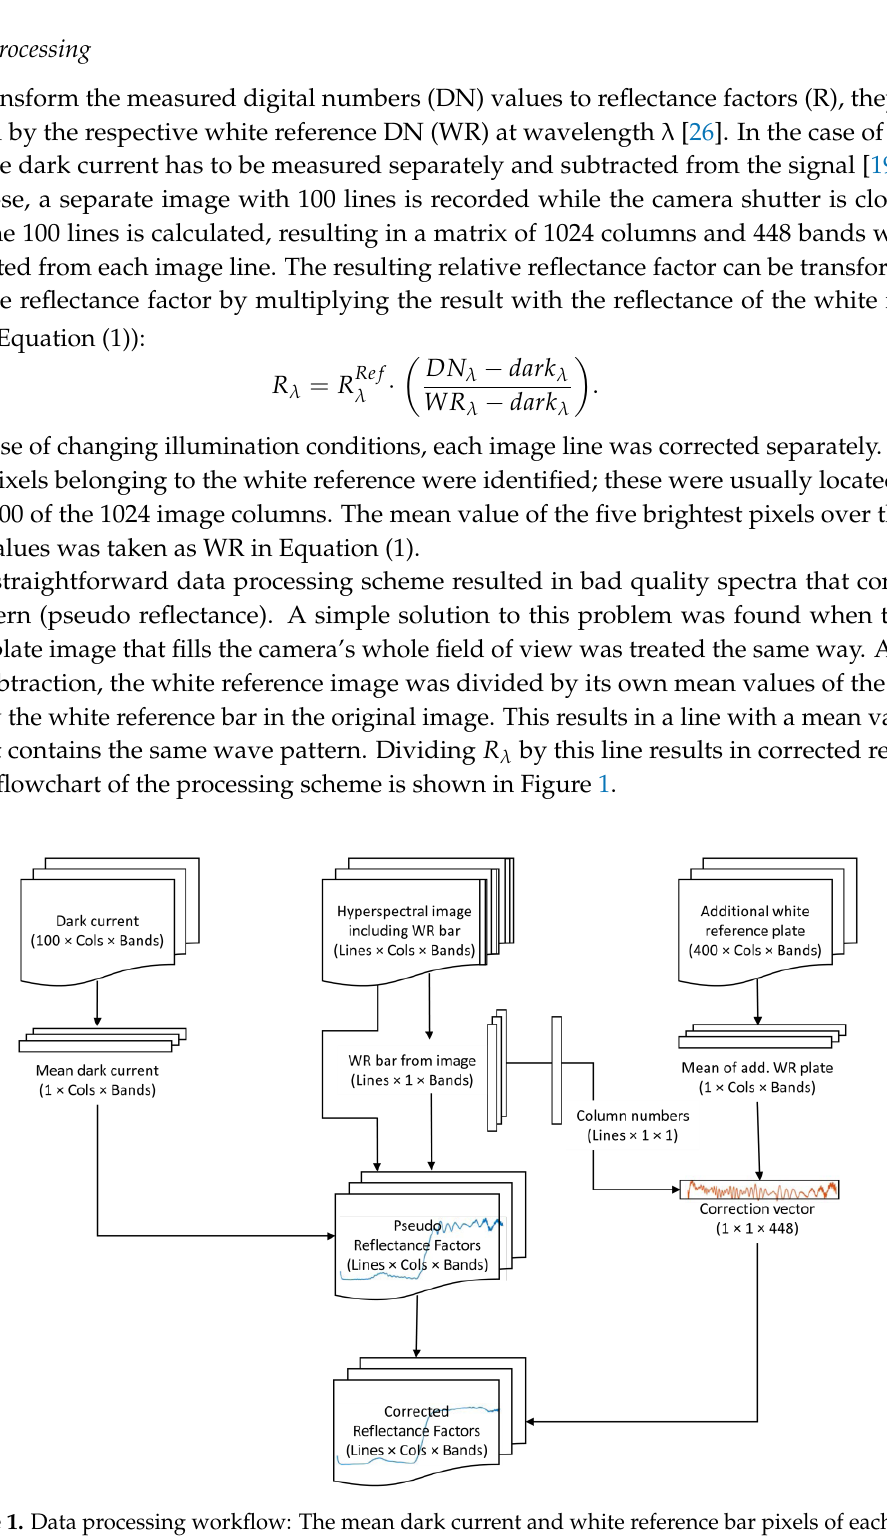
Figure 1. Data processing workflow: The mean dark current and white reference bar pixels of each line of the hyperspectral image are used to calculate pseudo reflectance factors. An additional hyperspectral data set of a white reference plate is transformed using the white reference bar pixel positions to create a correction vector which can be used to correct the pseudo reflectance data set. The size of each matrix is given. The camera employed in this study offers 1024 columns (cols) and 448 bands. The number of lines in the image and the image of the white reference plate are arbitrary. In a further step, the images were filtered using three criteria: Pixels with normalized difference vegetation index (NDVI) values greater than 0.4, near infrared reflectance (800 nm) greater than 0.18 and blue reflectance (460 nm) less than 0.1 were accepted as vegetation pixels, the other pixels were masked out. Mean spectra of the trees were calculated as mean values of all vegetation pixels.